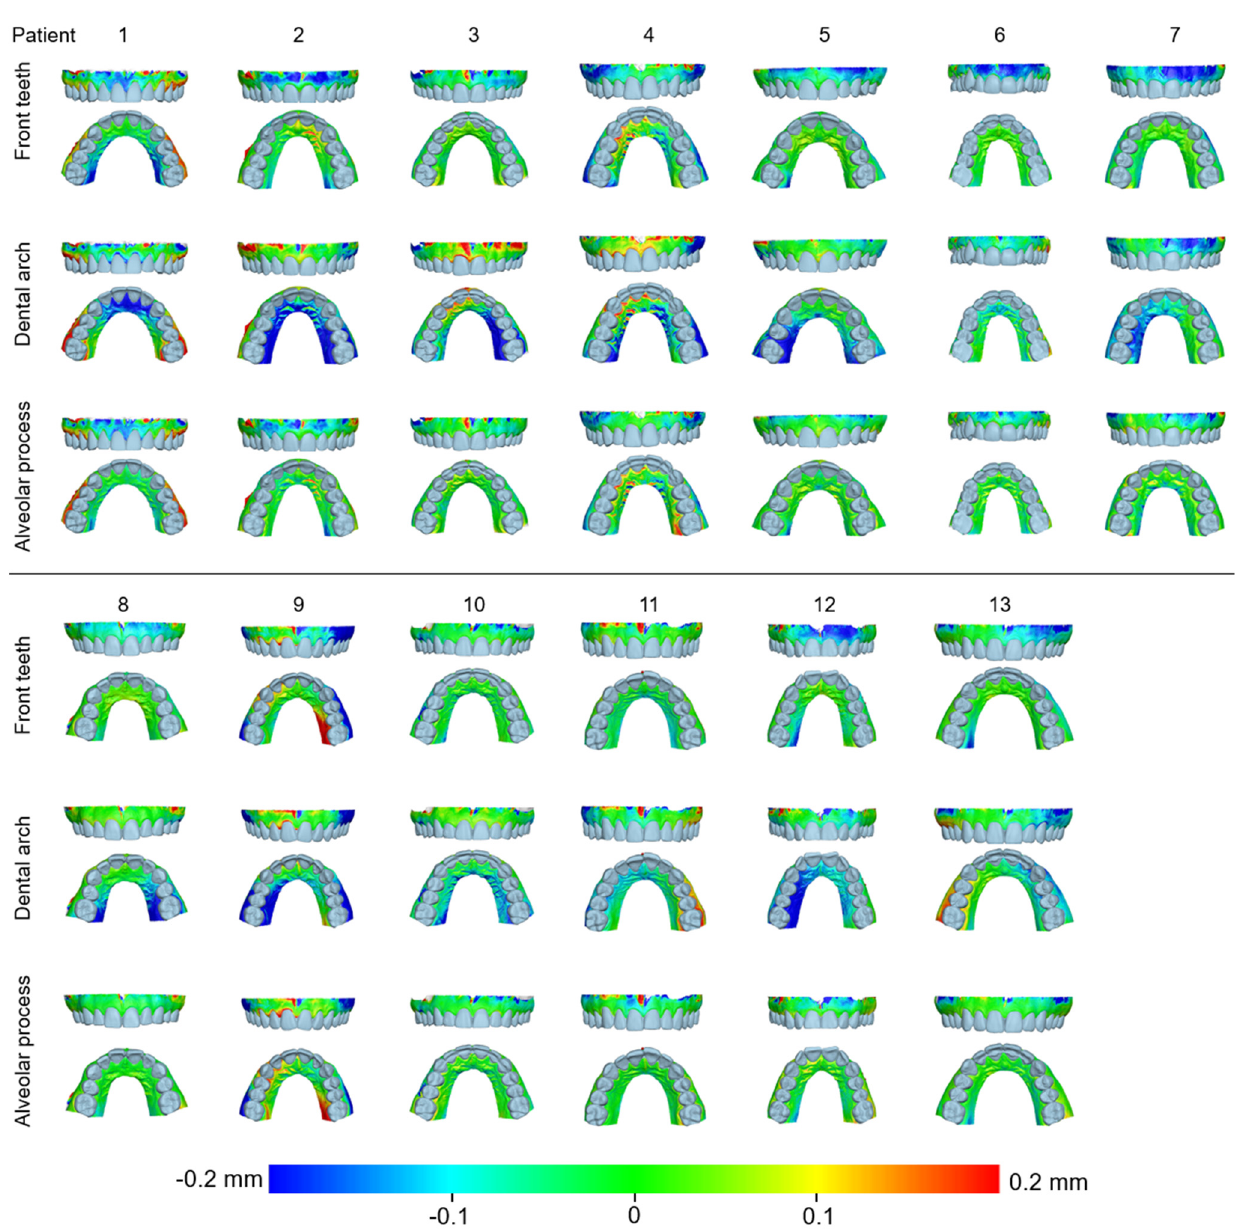
Figure 5. Color-coded distance maps showing the agreement between the intraoral scans at the buccal and palatal alveolar soft-tissue surfaces when superimposed on this area, the front teeth, or the dental arch. Three scans from CS 3600 (CS1, CS2, and CS3) and two scans from TRIOS3 (TR1 and TR2) were assessed.